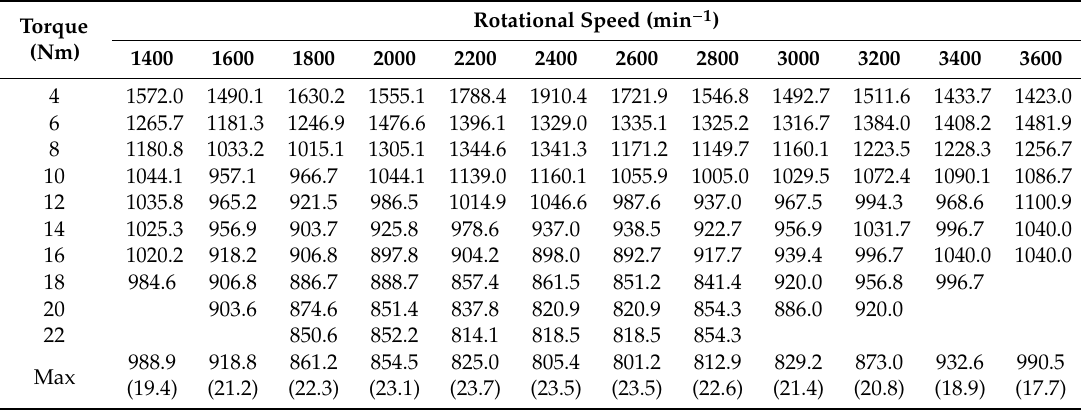
Table A5. CO 2 emission (g / kWh) from range extender supplied with LPG.